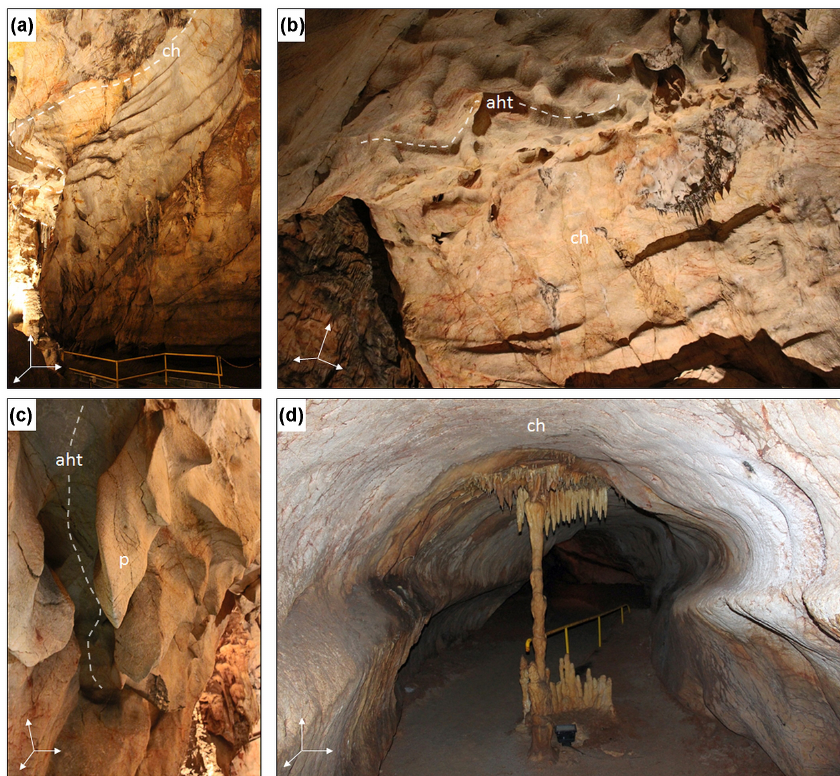
Figure 2. Examples of ceiling channels (ch), pendants (p), and anastomosing half tubes (aht) in the Domica cave as speleoforms associated with the phreatic regime. Presence of the speleoforms in the ceiling and walls of the Gothic Dome indicate paragenetic (antigravitational) development (a, b, c) , while it is more difficult to infer from the “dry passage” ( Suchá chodba in Slovak) (d) from where much of the accumulated sediment was not evacuated and the passage was reshaped during multiple phases of vadose and phreatic conditions. The highest parts of the channels can be situated as high as 16m (a, b) or 2m above the floor on sediment accumulation (d) .